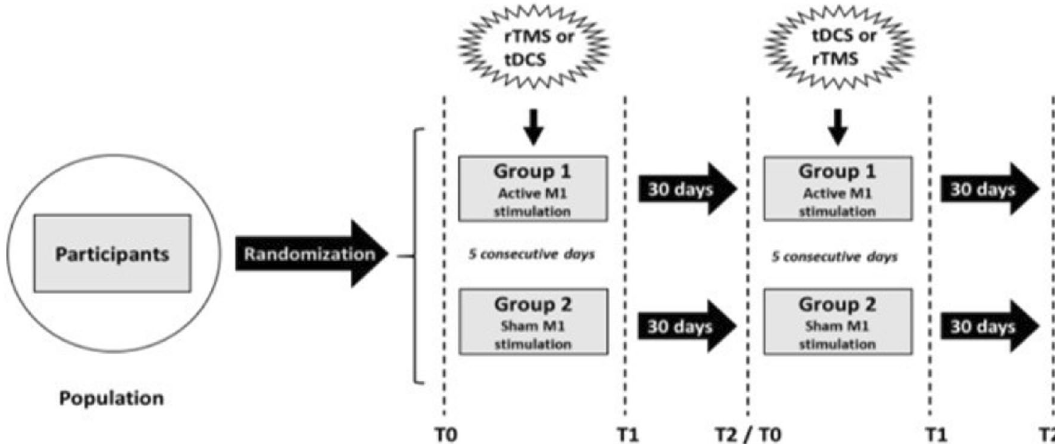
Figure 1. Study design. The treatment protocol included 2 stimulation blocks separated by a 30-day interval. Each block consisted of 5 sessions for 5 consecutive days, during which each patient received repetitive transcranial magnetic stimulation (rTMS) or transcranial direct-current stimulation (tDCS) for 30 min. Each patient underwent 10 stimulation sessions in all. Assessments took place immediately before the first stimulation (T0), after the 5th consecutive stimulation session (T1) and 30 days after (T2). M1 primary motor